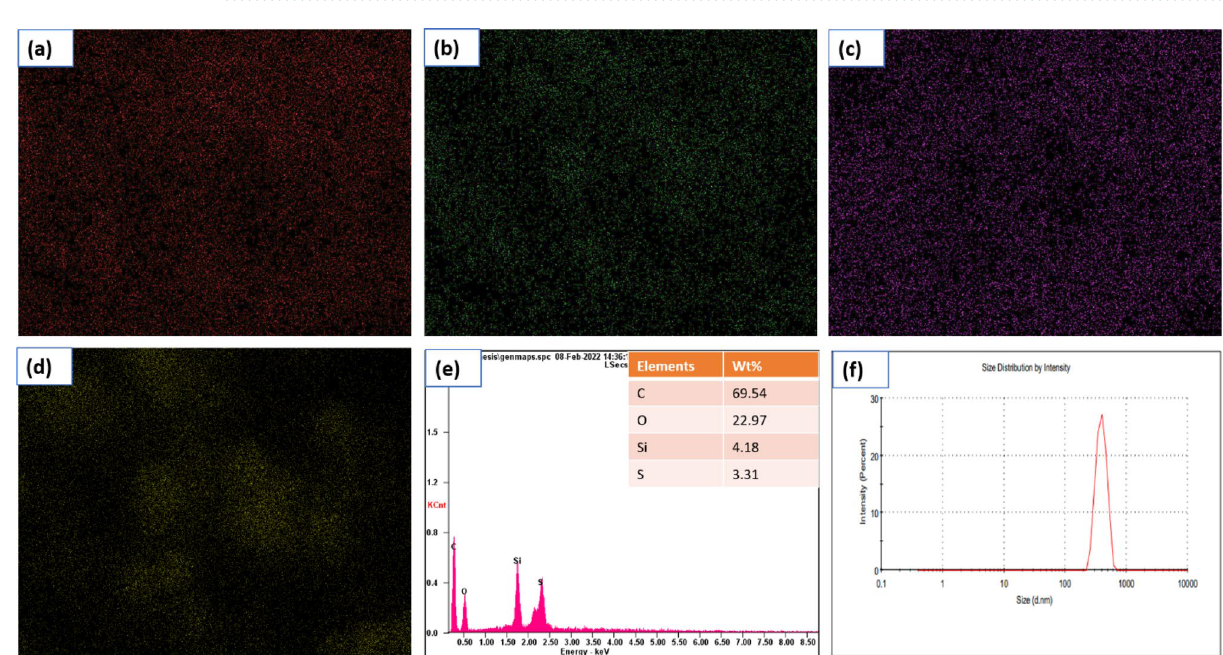
Figure 5. Mapping of the SANH18 catalyst showing ( a ) carbon, ( b ) oxygen, ( c ) sulfur, ( d ) silicon, ( e ) EDS analysis shows the presence of C, O, Si, and S, ( f ) particle size